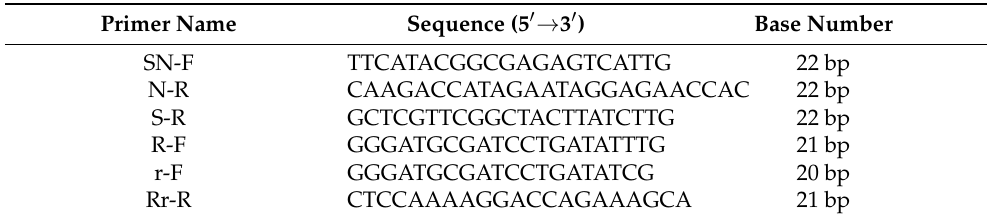
Table 1. Primers of molecular markers for identification of pol and shaan CMS three-lines as well as their hybrids in B. napus